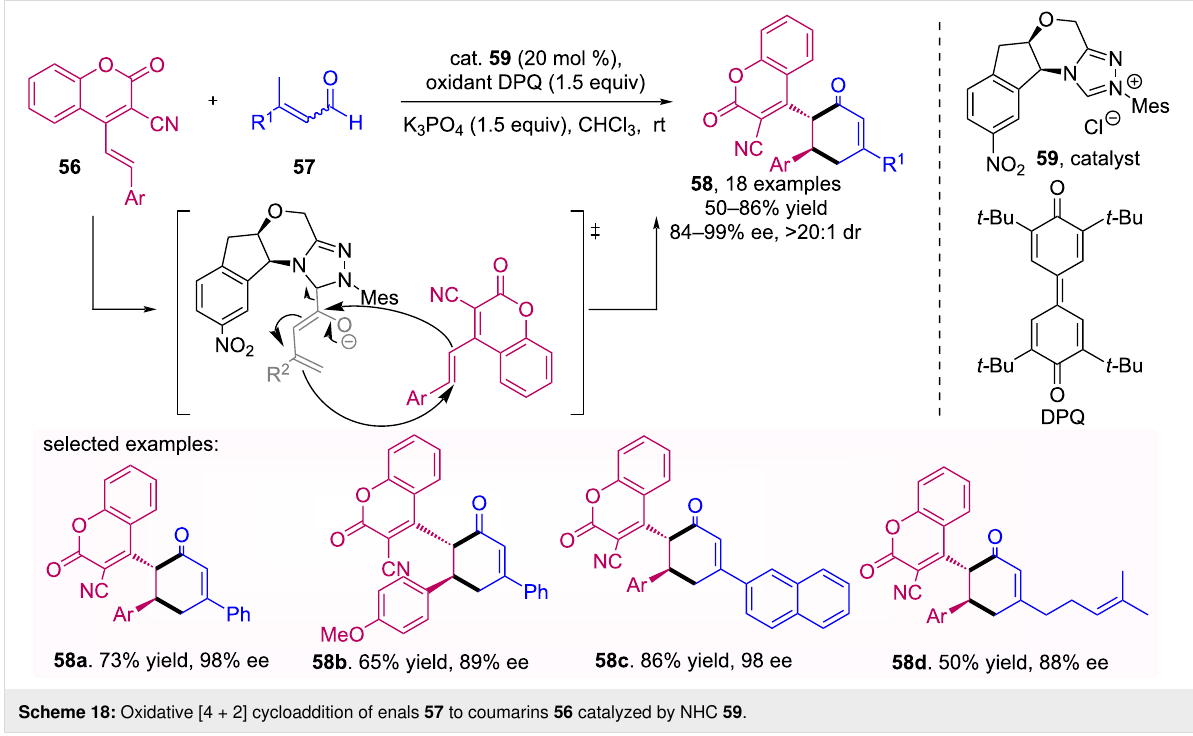
Scheme 18: Oxidative [4 + 2] cycloaddition of enals 57 to coumarins 56 catalyzed by NHC 59 .